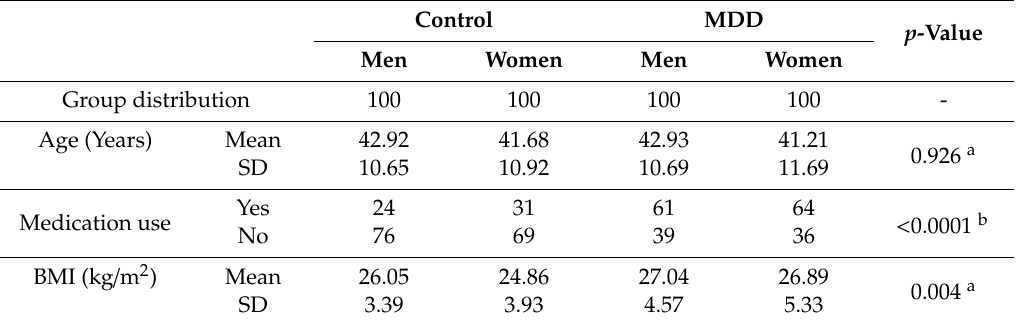
Table 1. Demographic and clinical characteristics of the study